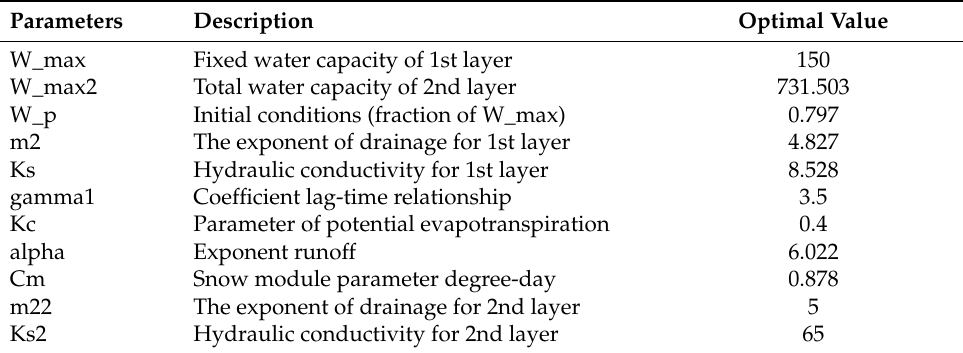
Table 2. Parameter setting of MISD